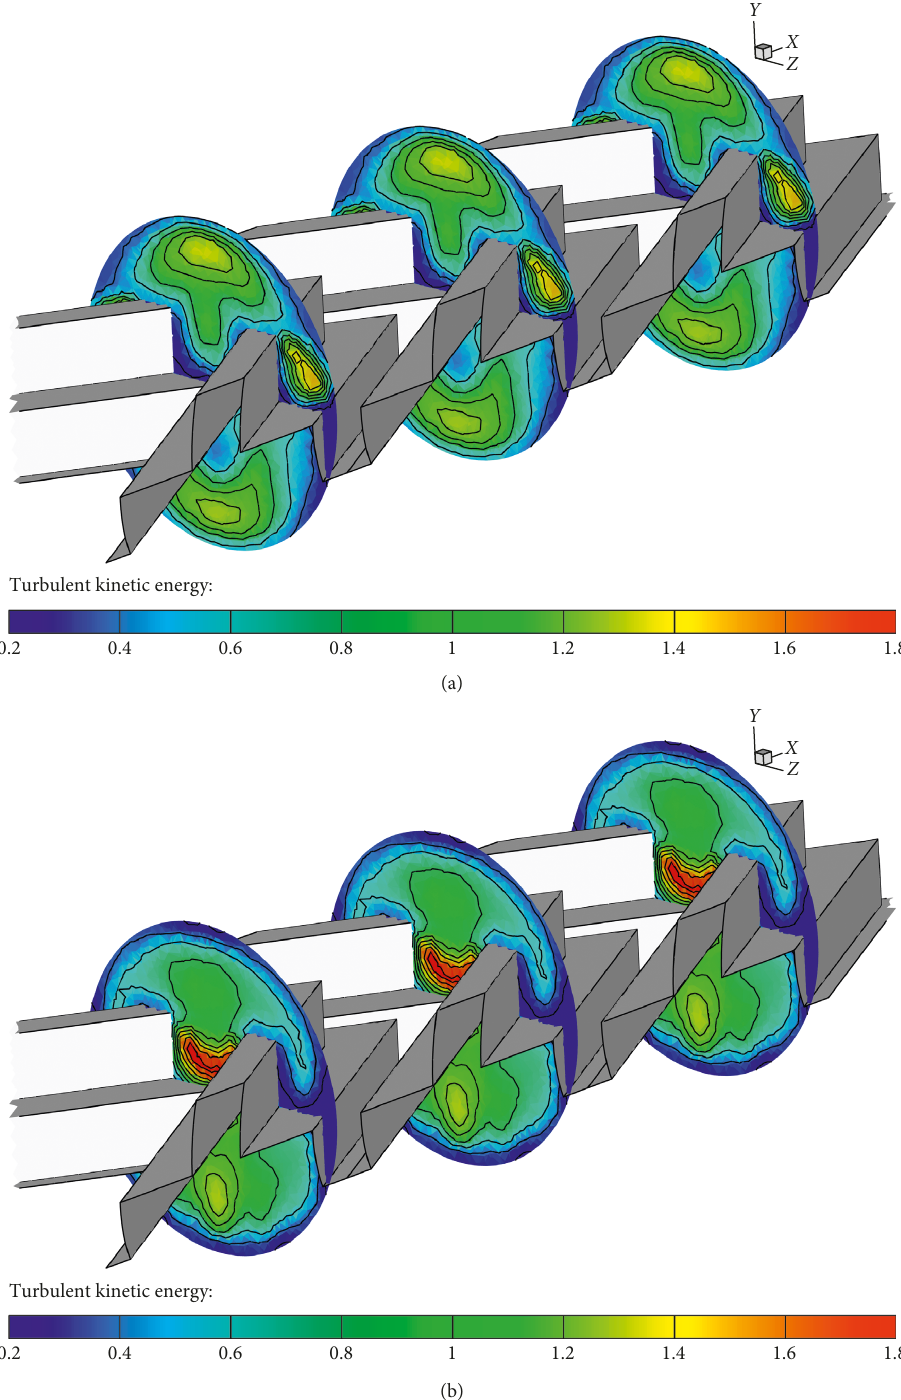
Figure 18: TKE in transverse planes of the heat exchanger tube inserted with the V-wavy surface at α Downstream and (b)